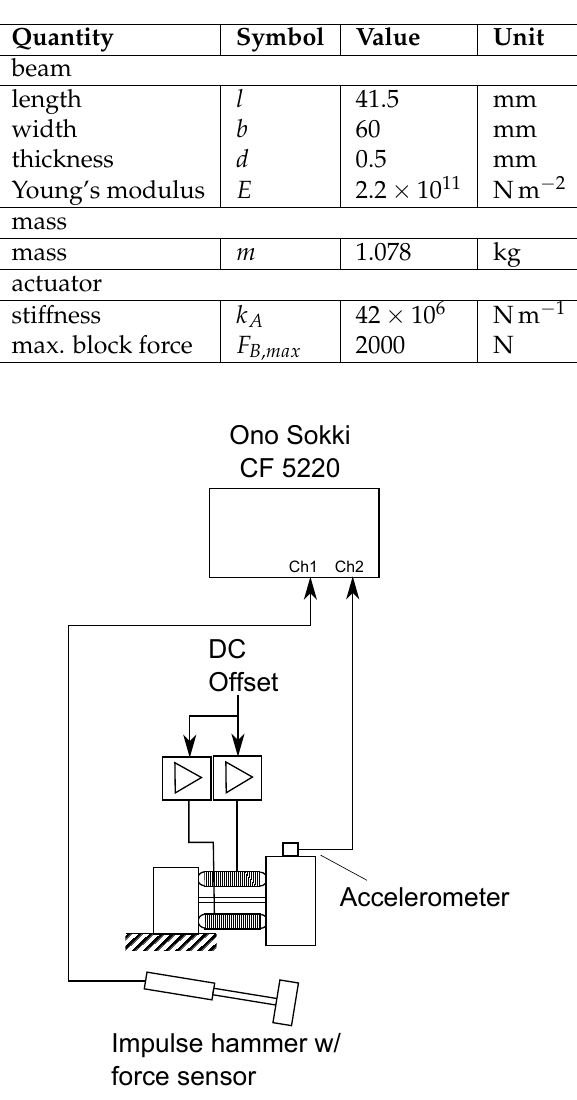
Table 2. Parameters of the adaptive vibration absorber.